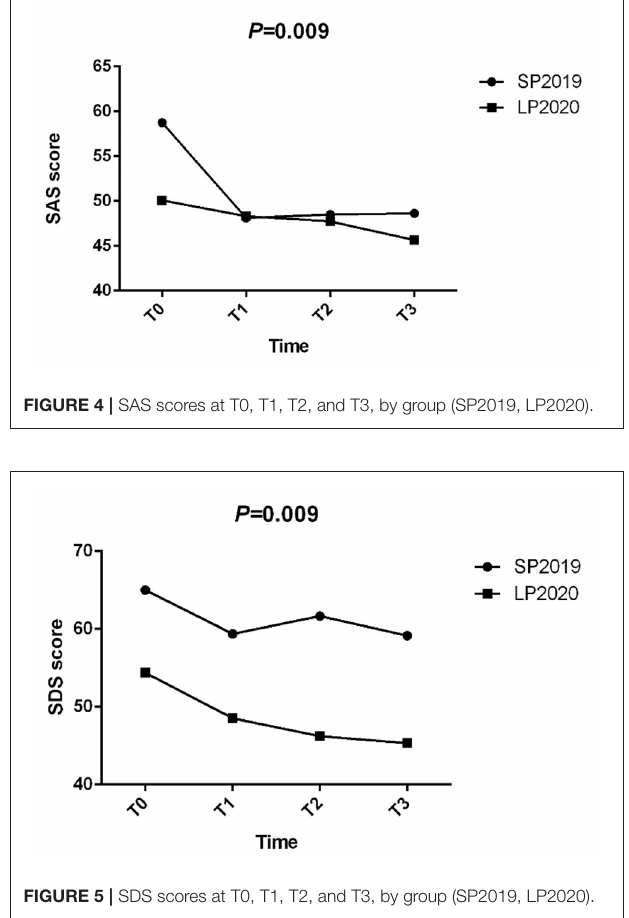
( t = 2.579, P = 0.011) and SDS ( t = 2.894, P = 0.004) scores